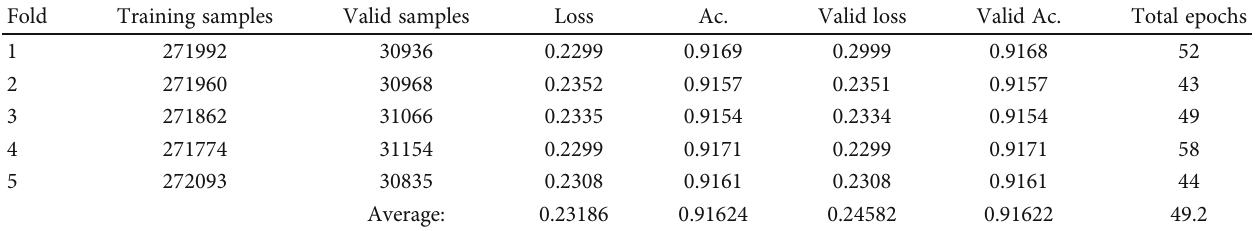
Table 6: Fivefold cross-validation result of GaitRec-Net architecture on the GaitRec dataset. Fold